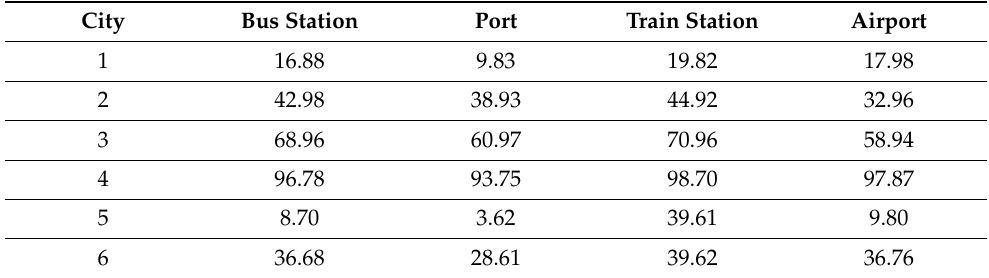
Table 3. Transit point coordinates of the simulated city (a).